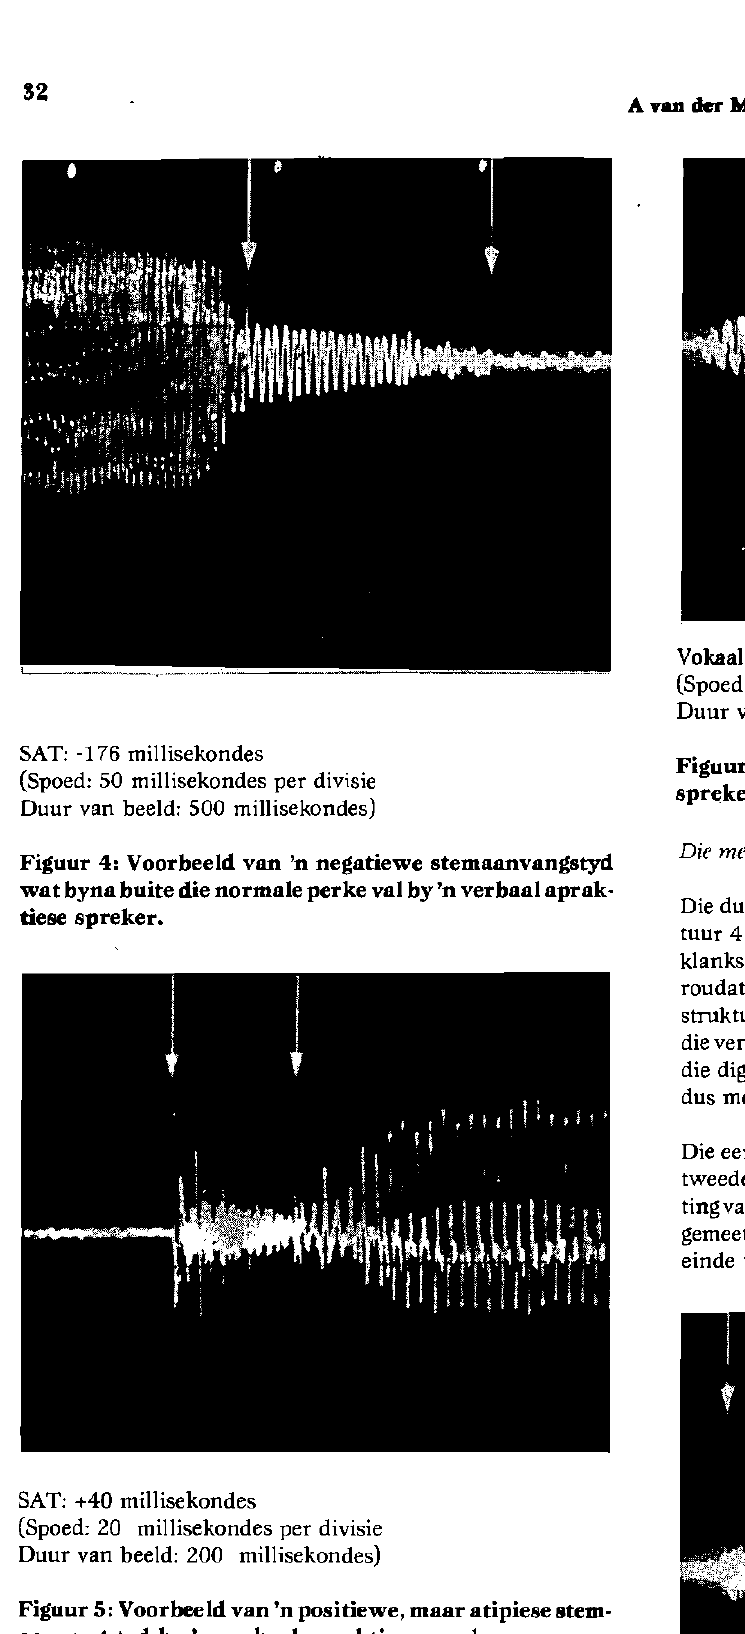
Figuur 5: Voorbeeld van 'n positiewe, maar atipiese stem- aanvangstyd by 'n verbaal apraktiese spreker. Die meting van vokaalduur.